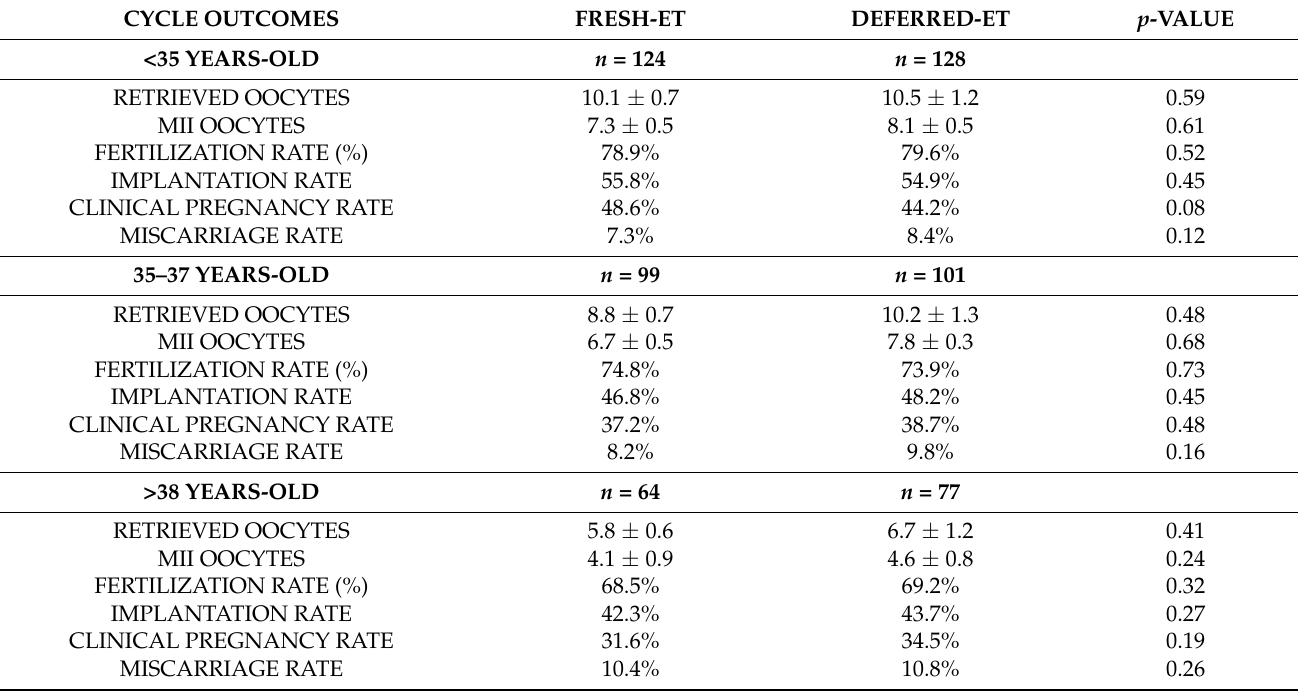
Table 3. Age-stratified IVF-ICSI outcomes in non-PGT-A Cycles.